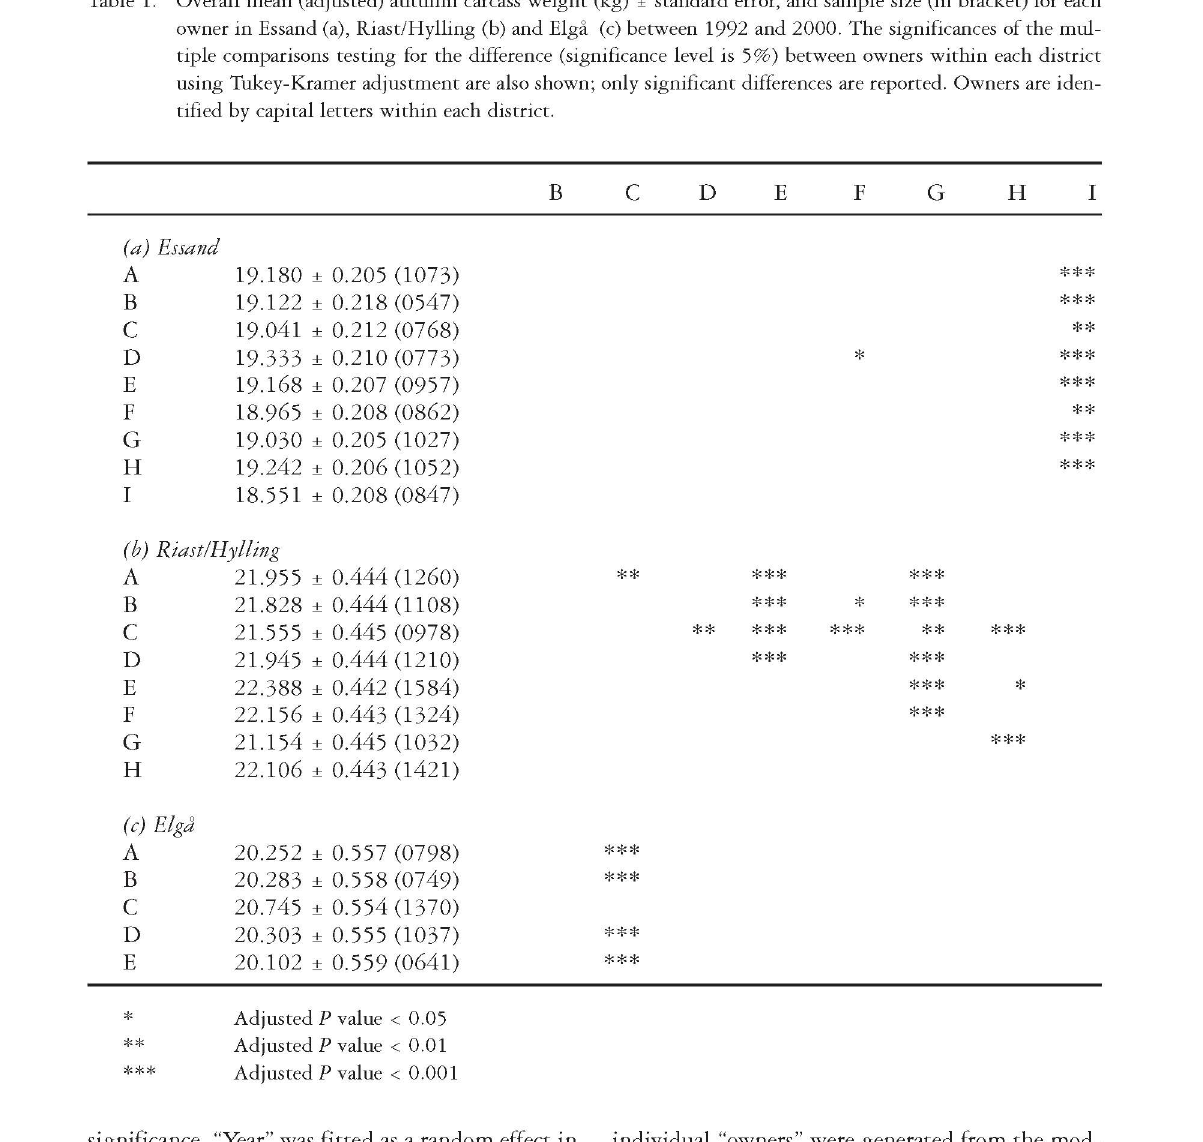
Table 1. Overall mean (adjusted) autumn carcass weight (kg) ± standard error, and sample size (in bracket) for each owner in Essand (a), Riast/Hylling (b) and Elgå (c) between 1992 and 2000. The significances of the mul¬ tiple comparisons testing for the difference (significance level is 5%) between owners within each district using Tukey-Kramer adjustment are also shown; only significant differences are reported. Owners are iden¬ tified by capital letters within each district.